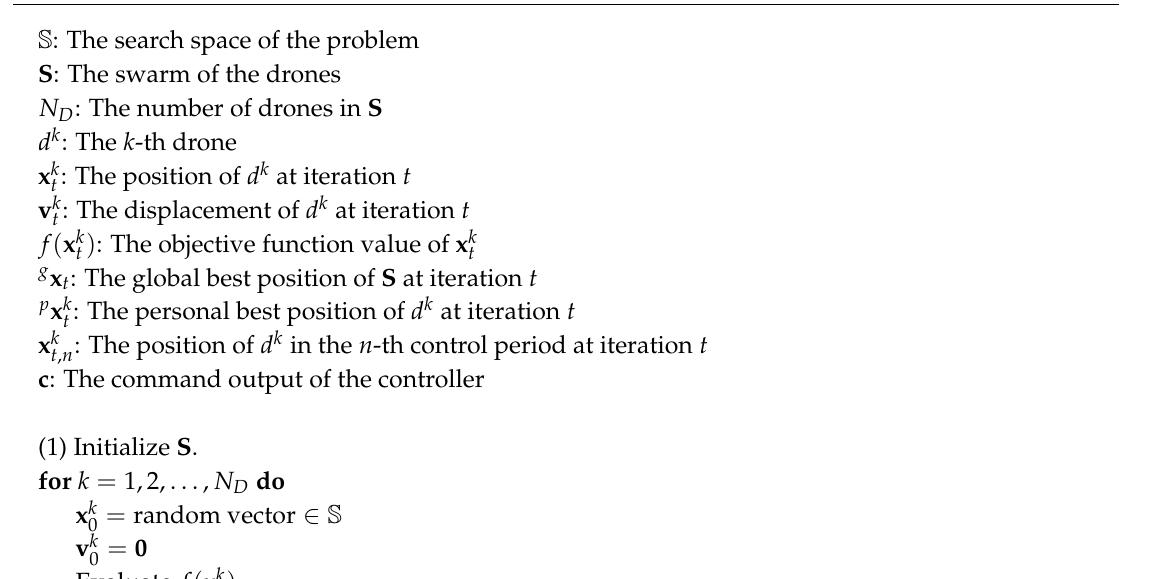
Algorithm 1 Swarm